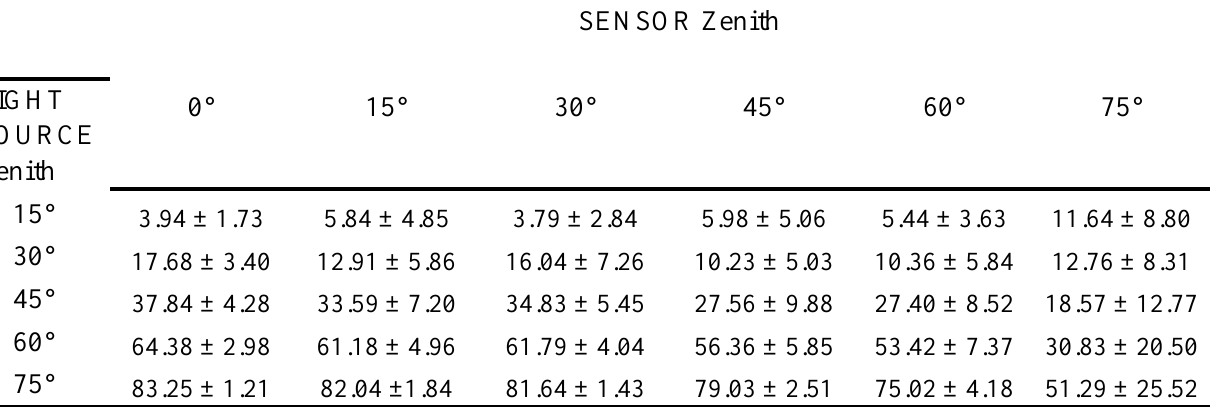
Table 1 . Mean Radiance differences and Standard Deviation in (%), relative to the centre of the light source for all light source azimuth positions (mean values) and for different light source zenith positions. Sensor readings were acquired for all zenith